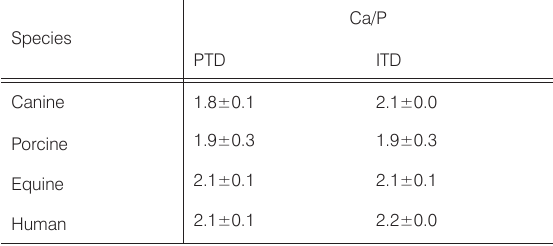
Values marked by the different lowercase letters in columns and uppercase letters in rows for each element are significantly different (P<0.05). Table 4. Means ± standard deviations of Ca/P ratios of canine, porcine, equine, and human peritubular (PTD) and intertu- bular dentin